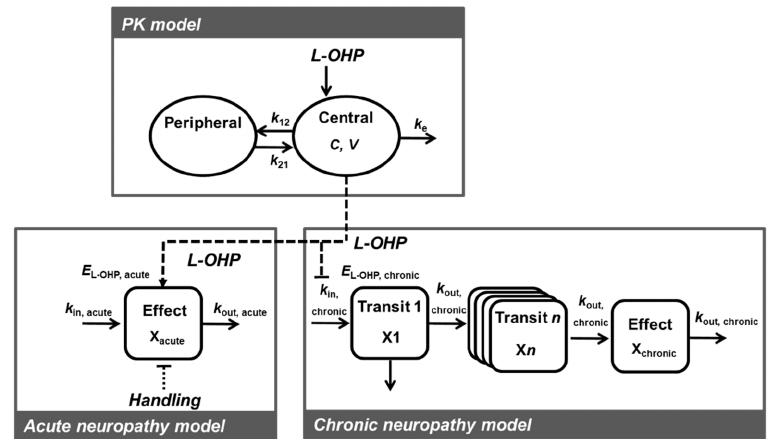
Figure 1. Schematic of the pharmacokinetic-toxicodynamic (PK-TD) model of oxaliplatin (L-OHP) induced acute and chronic neuropathy. C, L-OHP concentration in the central compartment; V , central volume of the distribution; k e , elimination rate constant from the central compartment; k 12 , rate constant of central compartment to peripheral compartment; k 21 , rate constant of peripheral compartment to central compartment; E L-OHP,acute , drug effect for acute neuropathy; E handling , handling effect; k in,acute , a zero-order rate constant describing the rate of increase of paw withdrawal responses; k out,acute , a first-order rate constant describing the rate of decrease of paw withdrawal responses; E L-OHP,chronic , drug e ff ect for chronic neuropathy; k in chronic , a zero-order rate constant describing the rate of increase of paw withdrawal threshold; k out,chronic , a first-order rate constant describing the rate of decrease of paw withdrawal